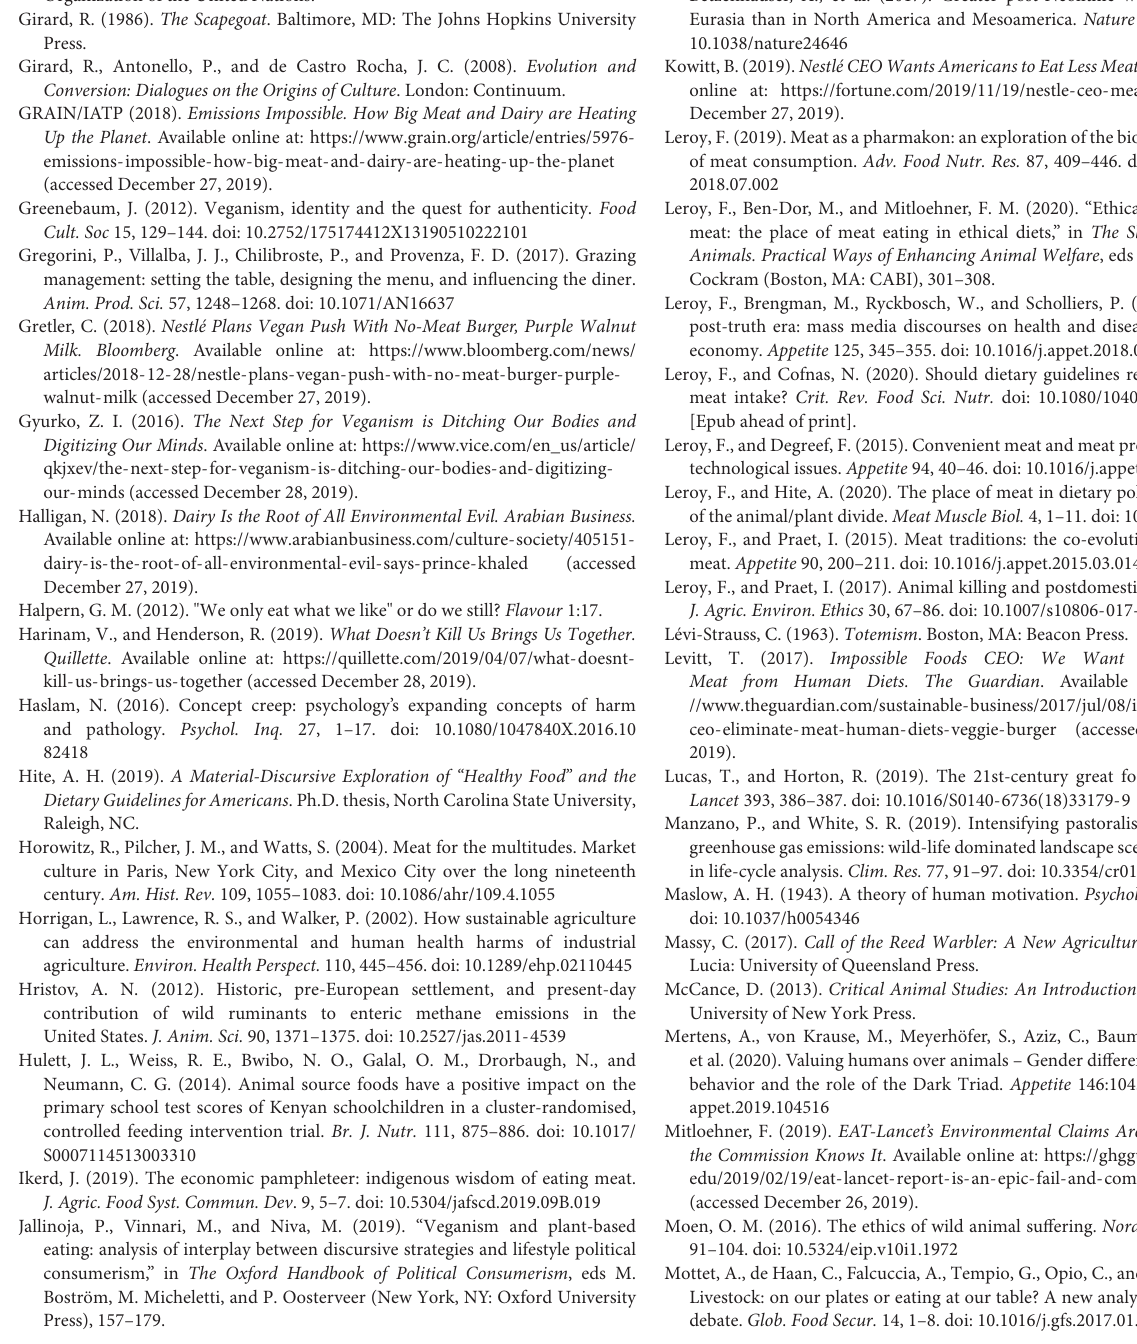
Frontiers in Sustainable Food Systems |